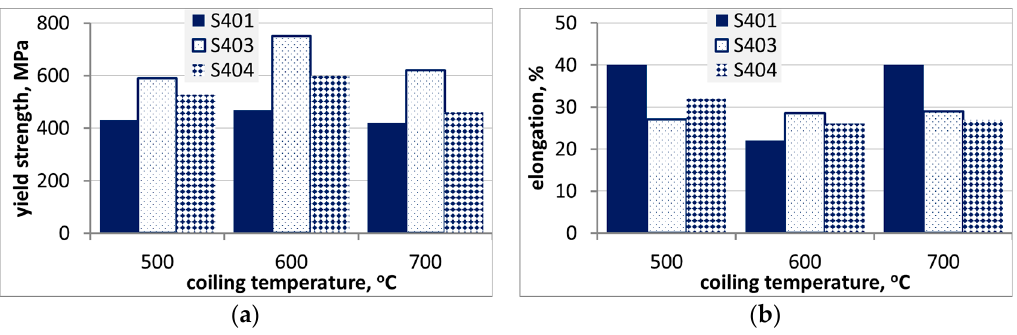
Figure 8. Yield strength ( a ) and elongation ( b ) of HSLA steels after various coiling temperatures.